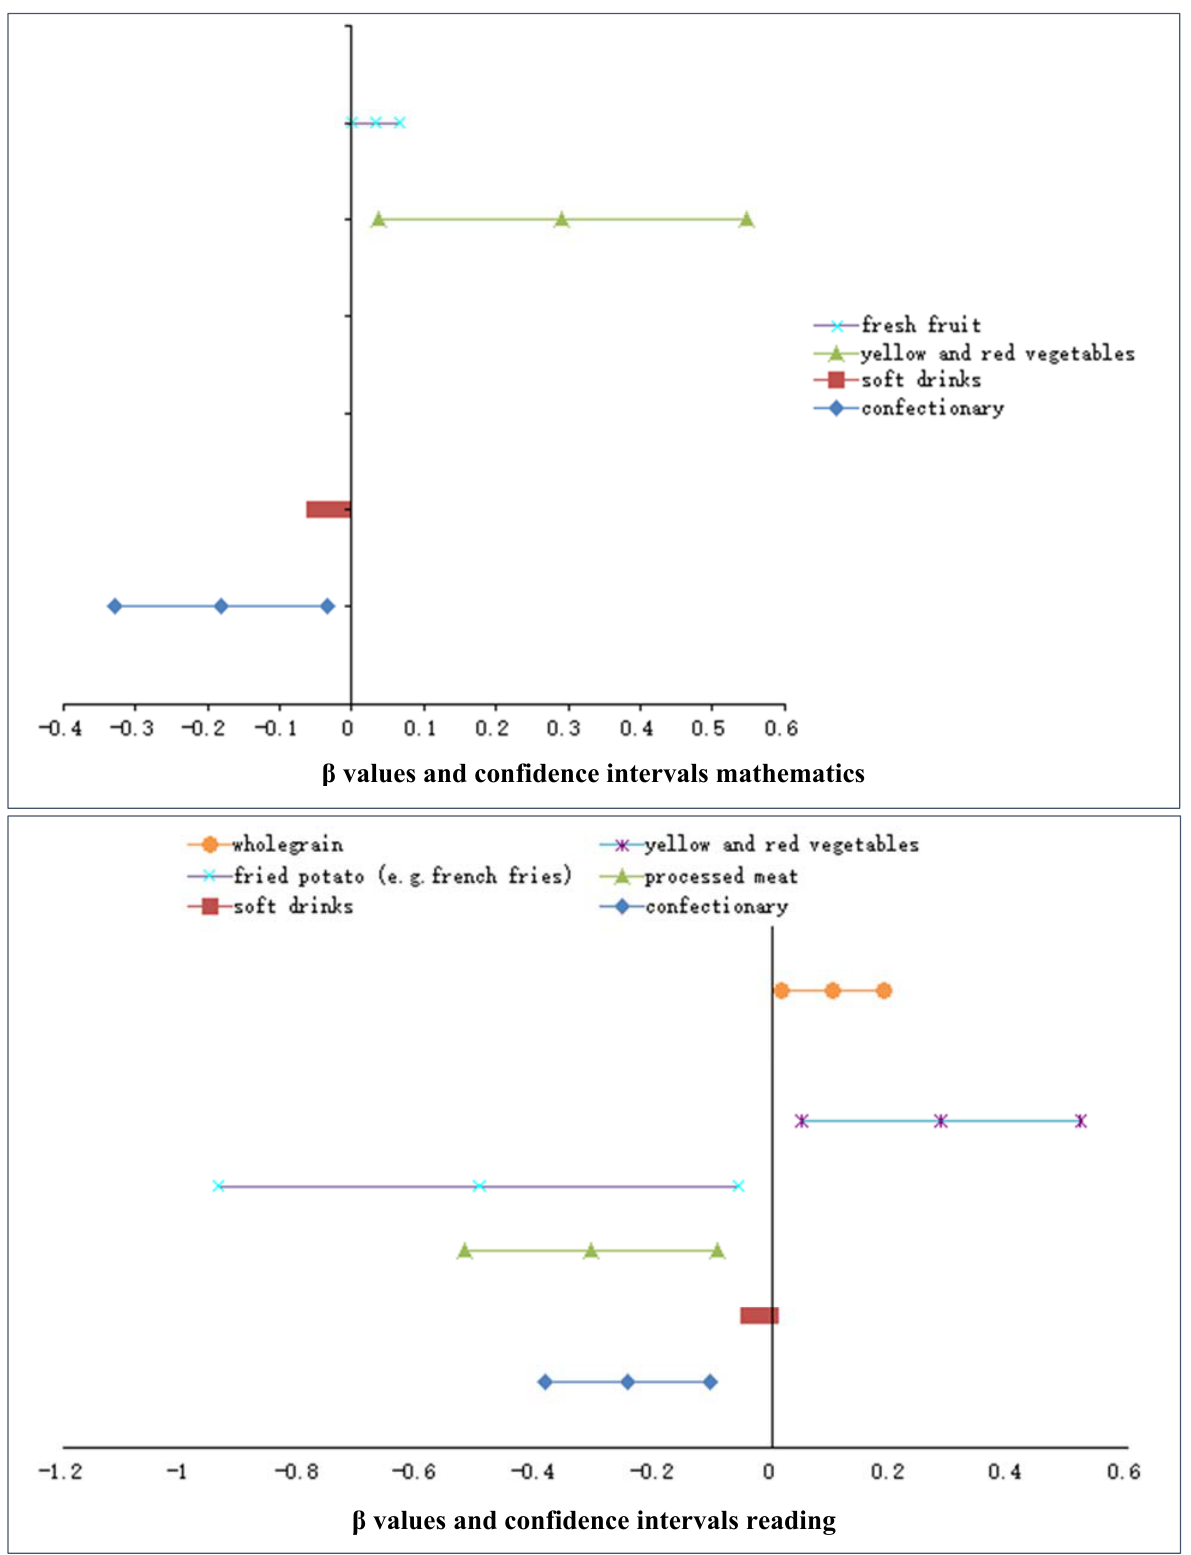
Figure 2. Significant associations in multivariable regression models between food groups and academic outcomes (mathematics and reading) in the Raine Study illustrated in forest plots by β values and 95% confidence